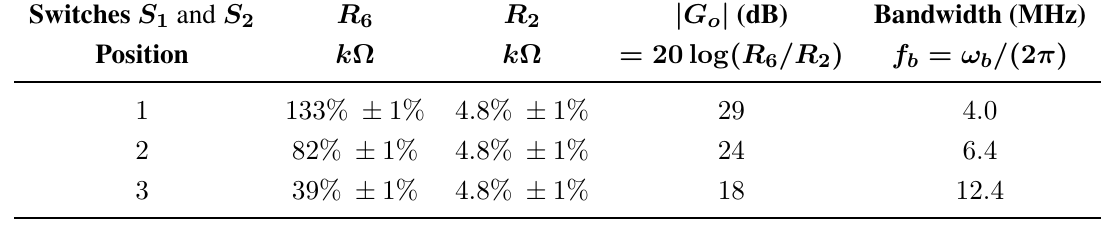
Table 5. Quantitative assessment of closed-loop differential amplifier gain and bandwidth.